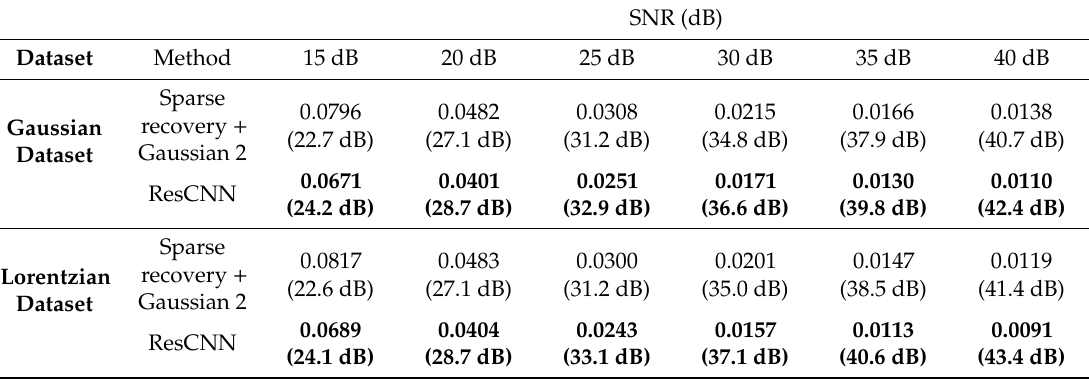
Table 3. Average RMSE and PSNR under various signal-to-noise ratios (SNRs, dB) with synthetic